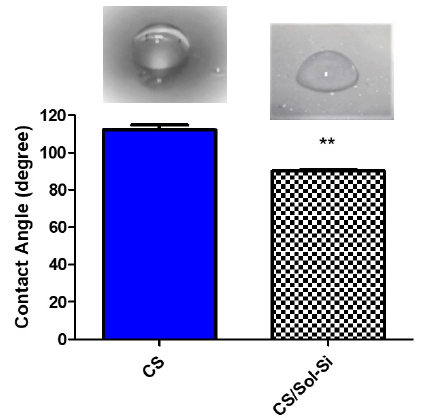
Figure 4. Contact angle of CS and CS/Si-Sol biocomposite. **( p < 0.0001) according to Student’s t -test.